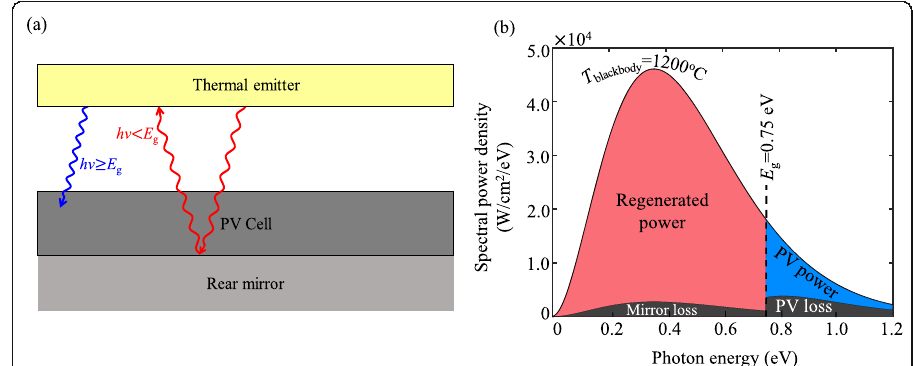
Fig. 1 Power conversion in regenerative thermophotovoltaics. Photons with energies below the band-edge of thermophotovoltaic cell are reflected by the mirror to reheat the emitter. This results in